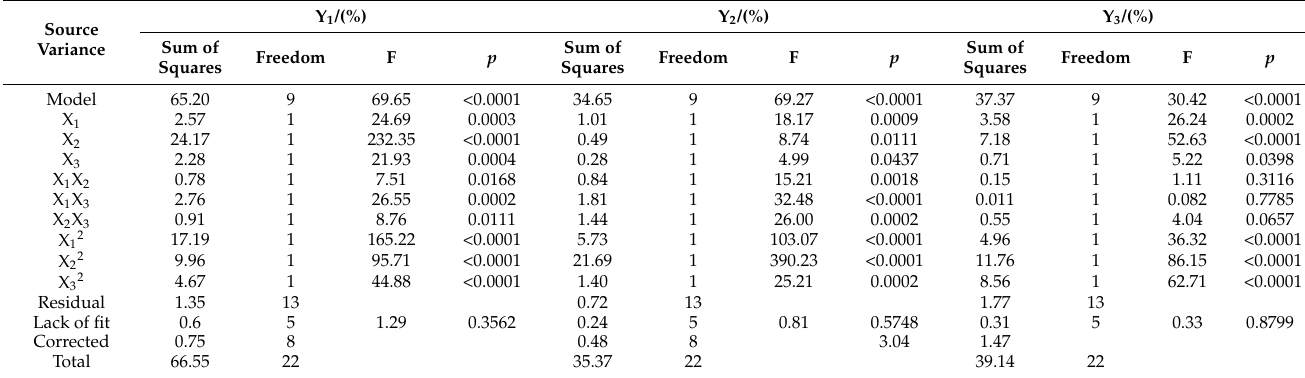
Table 7. Variance analysis.